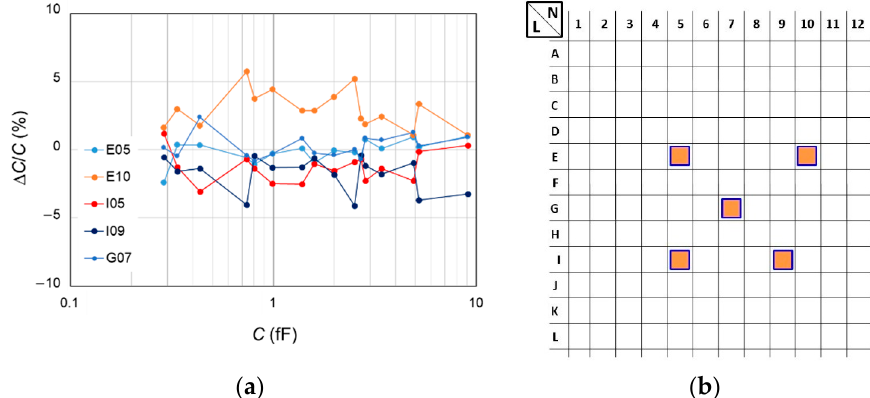
Figure 10. ( a ) Differences Δ C / C = (< C j,k > − C j,mean )/ C j,mean in percentage between the average < C j,k > of the measured values from the three capacitors of same type j (same area, same plateau) from the k th pattern (E05, E10, I05, I09, G07) of A64 sample and the mean values C j,mean calculated from the 5 patterns. The SMM is calibrated using triplet (05,13,48) from the G07 pattern. ( b ) Localisation of the patterns E05, E10, I05, I09 and G07 inside a zone of 1.28 × 1.60 mm 2 of the A64 sample. The error bars varying between 2% and 3% have been omitted for clarity.